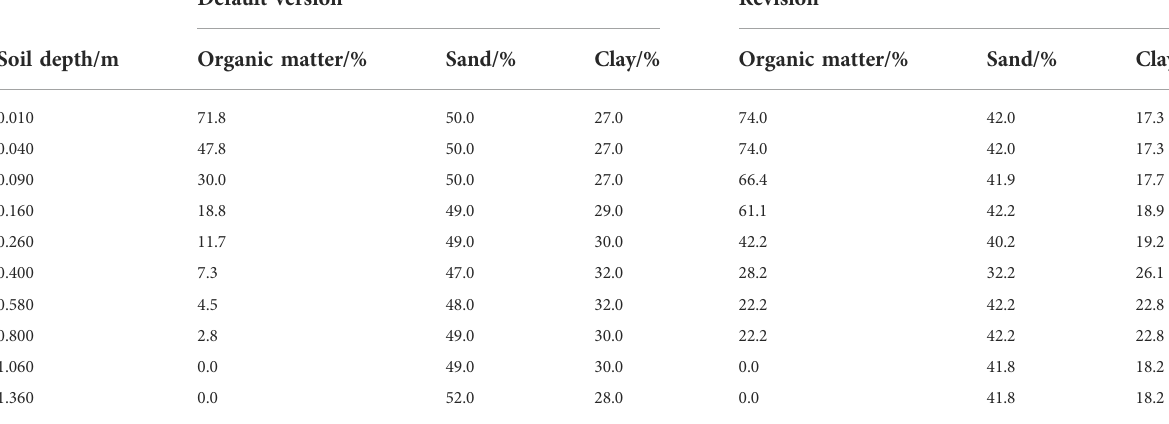
TABLE 1 Modi fi cation of soil properties at Motuo station.